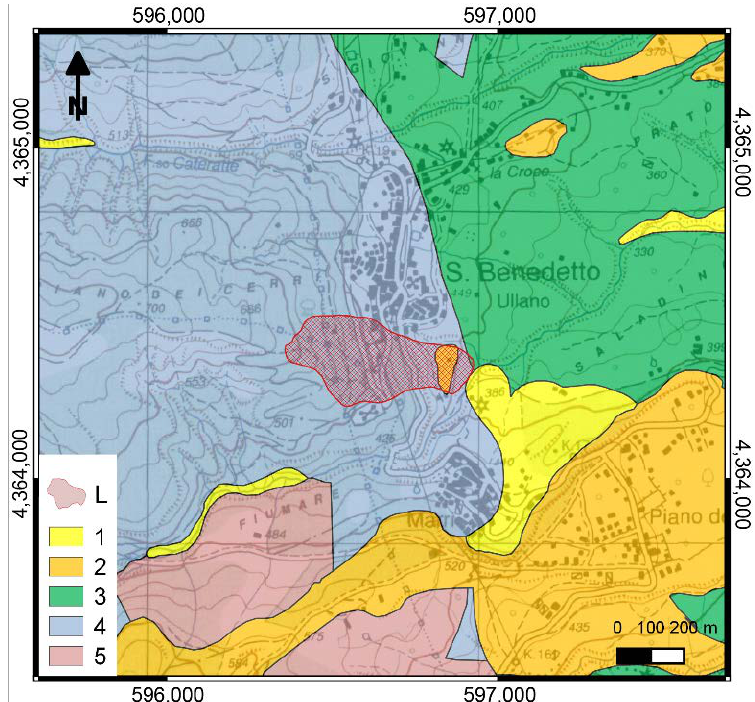
Figure 4. Lithological sketch of the San Rocco landslide at San Benedetto Ullano. Key: (1) Alluvium, colluvium, and residual soil; (2) conglomerate and sandstone; (3) Clay and clayey flysch; (4) Igneous and medium-high grade metamorphic rock; (5) Argillite and low-grade metamorphic rock. The landslide (L) is marked by a red hatched polygon. Topographic base map after 1:25,000 IGMI sheets; lithological map after [47], Geological map of Calabria (scale 1:25,000), mod.